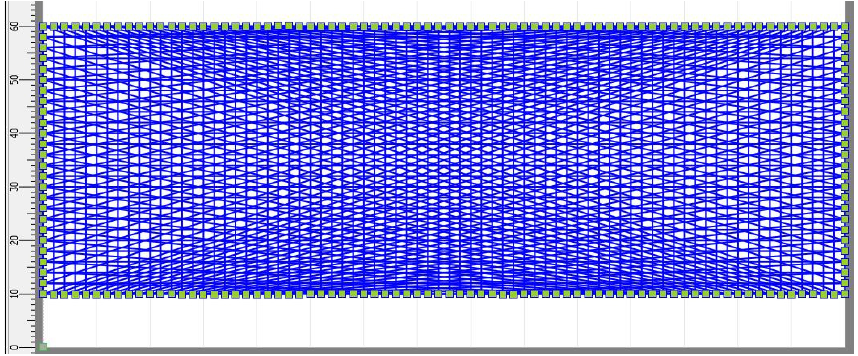
Figure 1. A 2D model of the melt electrospun PLA scaffolds; top view of the first layer; all six layers are identical. are identical.